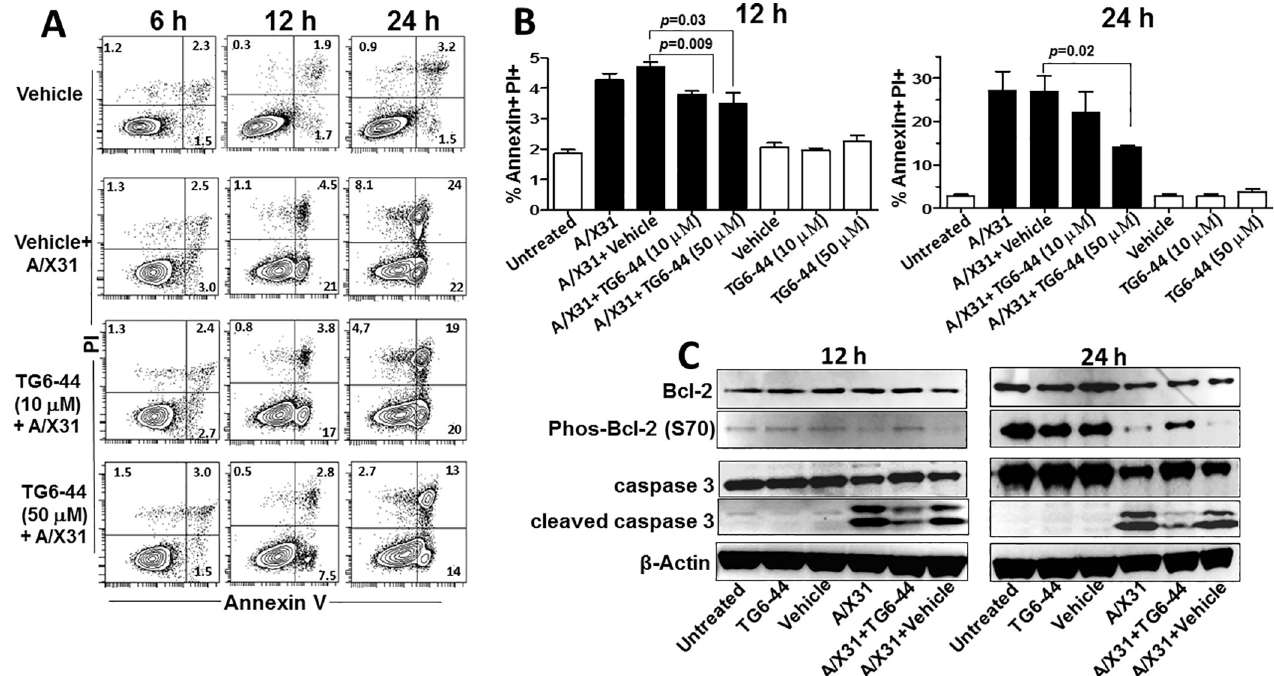
Fig 6. TG6-44 treatment leads to decrease in A/X31-induced cell death in THP-1 cells. A & B: A/X31-infected THP-1 cells treated with vehicle and/or TG6- 44 were analyzed for percent annexin V + and PI + cells at 6, 12, and 24 h p.i. Representative FACS plots (A) and accumulative data from three independent experiments (B) are shown. Values in panel B represent percent mean ± SEM. C: Cell lysates from A/X31-infected THP-1 cells treated with vehicle and/or TG6- 44 (50 μ M) were assayed for Bcl-2, phosho Bcl-2, caspase-3, cleaved caspase-3, and β -actin, by western blot assay, as described in Materials and Methods. Data represent results from one of three independent